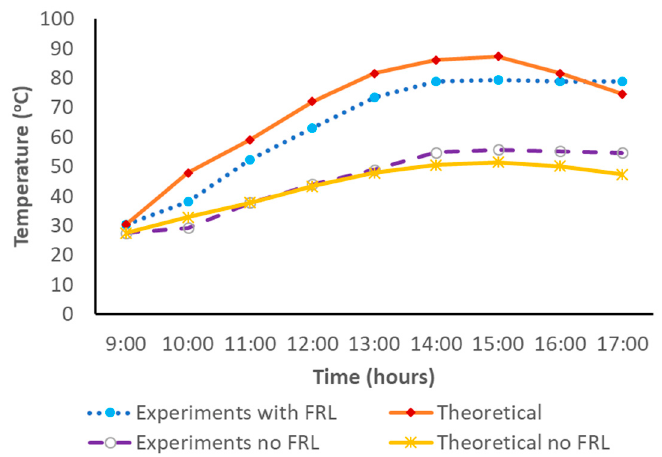
Figure 6. Hourly variation of experimental and theoretical values of water temperatures.